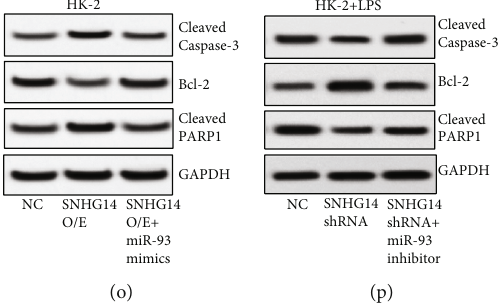
Figure 3: SNHG14 modulates oxidative stress, in fl ammation, and apoptosis of LPS-induced HK-2 cells via miR-93. (a) Predicted binding site of miR-93 in SHNG14 mRNA. (b) Expression level of miR-93 in LPS-treated HK-2 cells. (C) RIP assays performed using Ago2 antibody exhibited the enrichment of SNHG14 and miR-93. (d) Luciferase assays showed that overexpressing miR-93 decreased the activity of luciferase reporter containing wild-type SNHG14 sequence. (e – p) HK-2 cells were transfected with SNHG14 overexpression plasmids and miR-93 mimics, and LPS-induced HK-2 cells were transfected with SNHG14 shRNAs and miR-93 inhibitor; oxidative stress (e – h), in fl ammation (i – l), and apoptosis (m – p) were assessed as described above. Data were shown as mean ± SD , ∗ P < 0 : 05 .